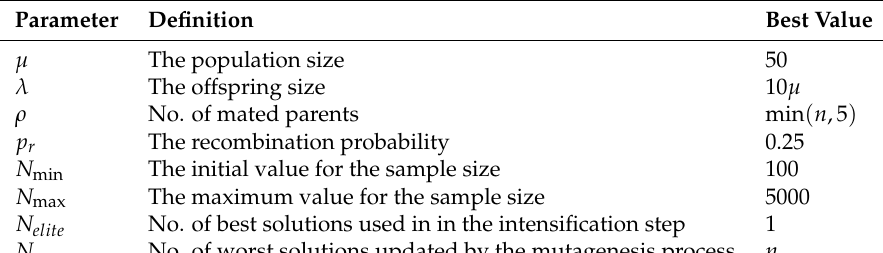
Table 4. DES and DESSP parameters.